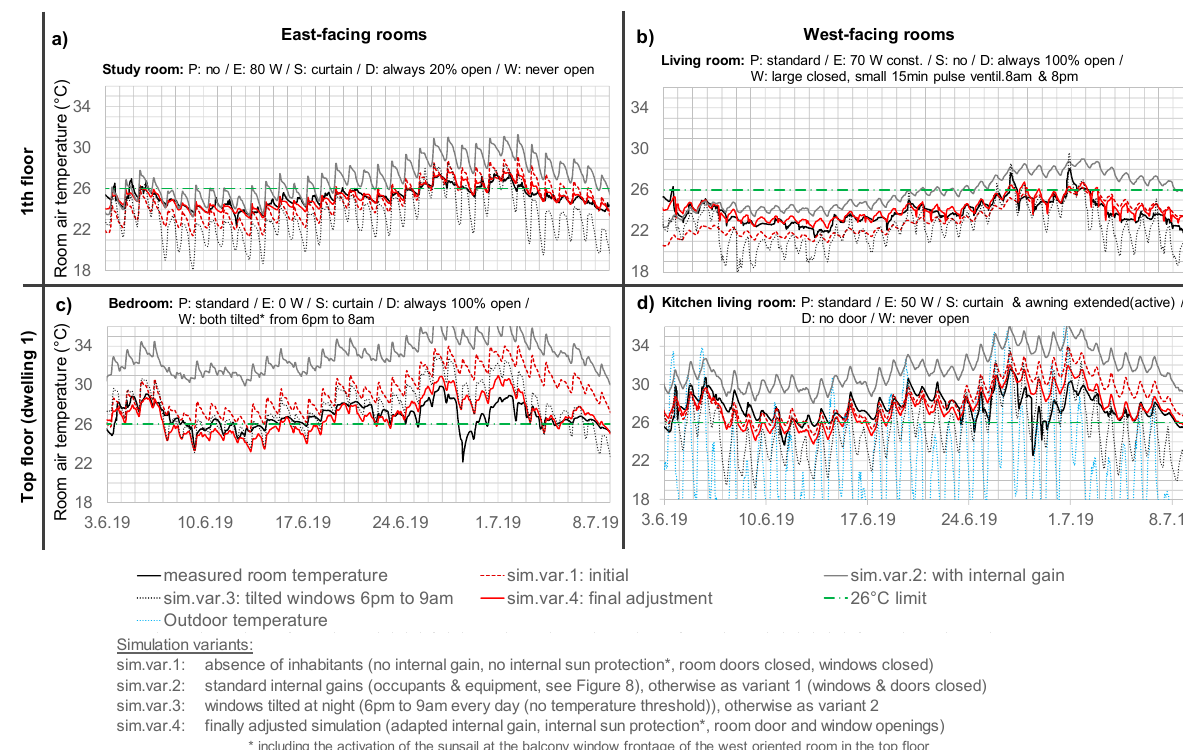
Figure 5. Measured (black curve) and four variants of simulated room temperature profiles for ( a , c ) east and ( b , d ) west façade oriented rooms for dwellings in the first and top floor including resident presence and behavior. The simulation parameters for the individual rooms of the final calibrated simulation variant 4 are written above each diagram. The comparison for all monitored rooms can be found in Figure 6.